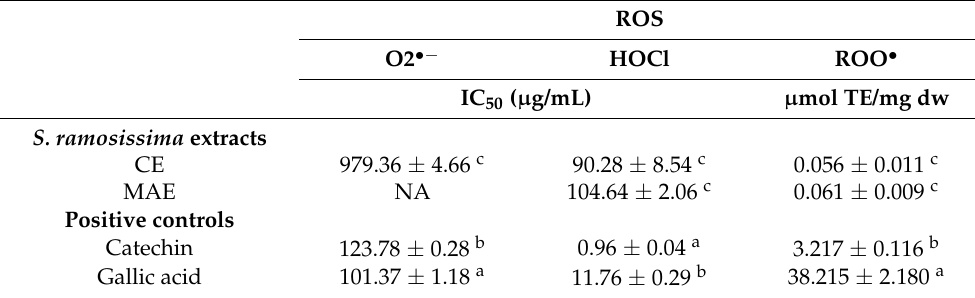
Table 3. Superoxide anion radical (O 2 •− ), hypochlorous acid (HOCl), and peroxyl radical (ROO • ) scavenging capacities of S. ramosissima extracts obtained by CE and MAE. Different letters (a, b, c) in the same column mean significant differences ( p < 0.05) between different